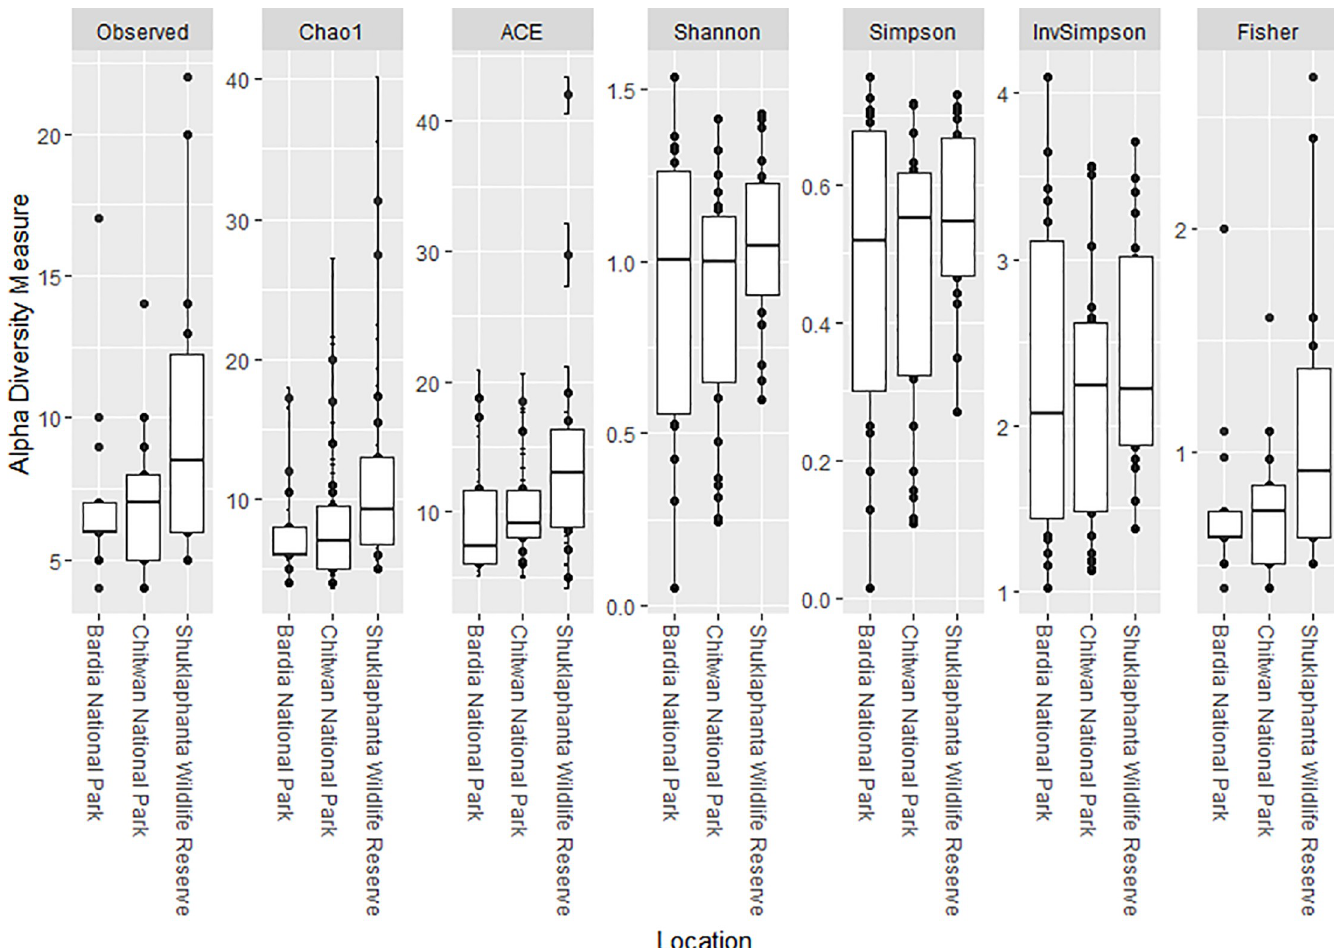
Fig 5. Alpha-diversity in tiger gut microbial communities is similar across different regions